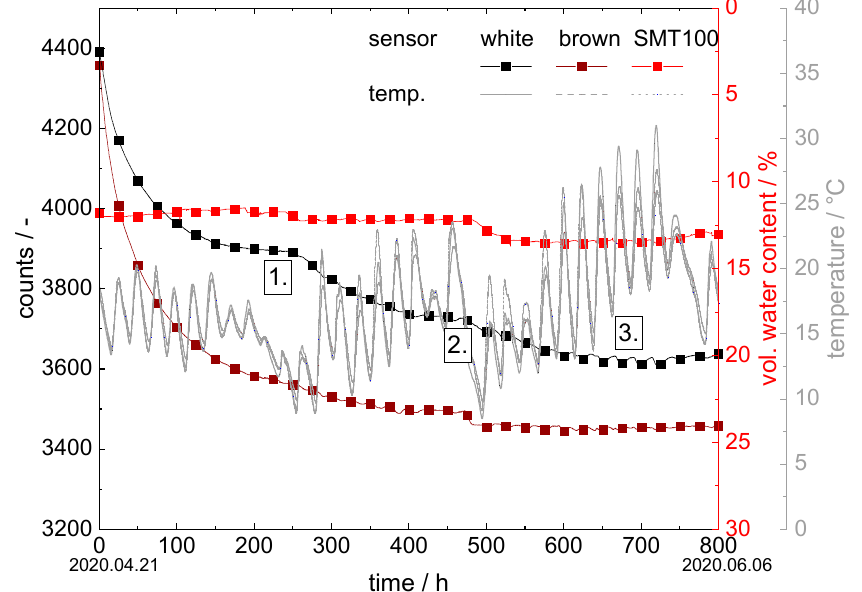
Figure 4. Soil moisture measurement experiment at Hegehof in asparagus field: counts are plotted versus time in hours for our new sensors; vol. water content vs. time for the SMT100.